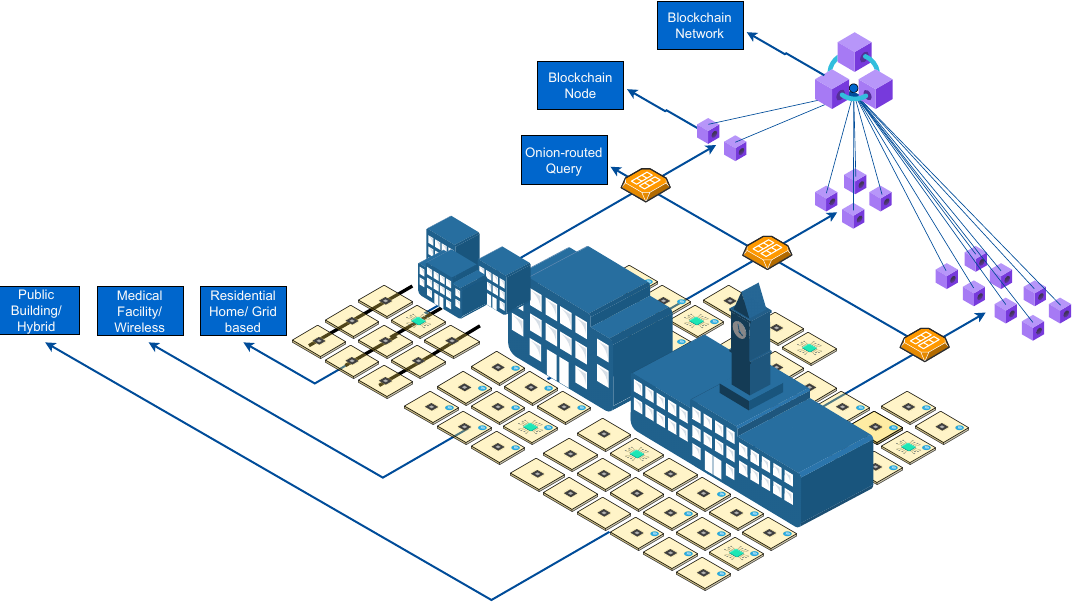
Figure 1. High level view of the presented